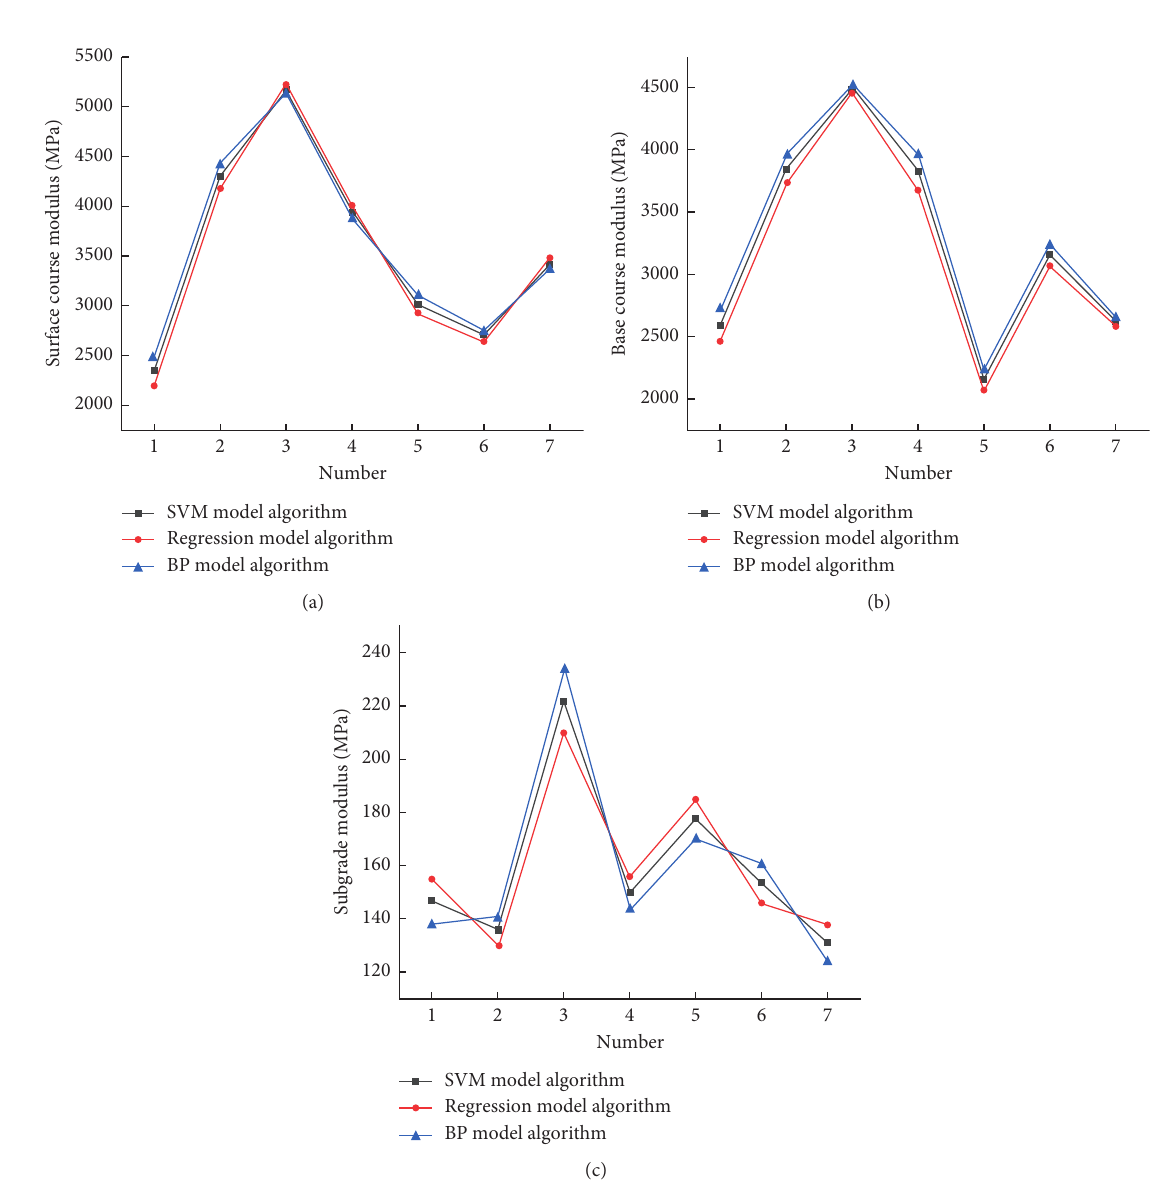
Figure 6: Comparison of inversion results of different inversion